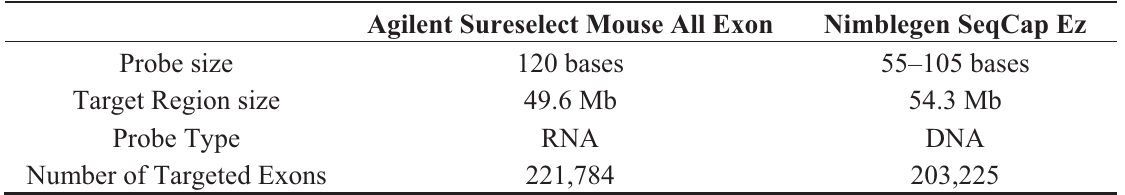
Table 1. Comparison between two standard whole exome mouse capture